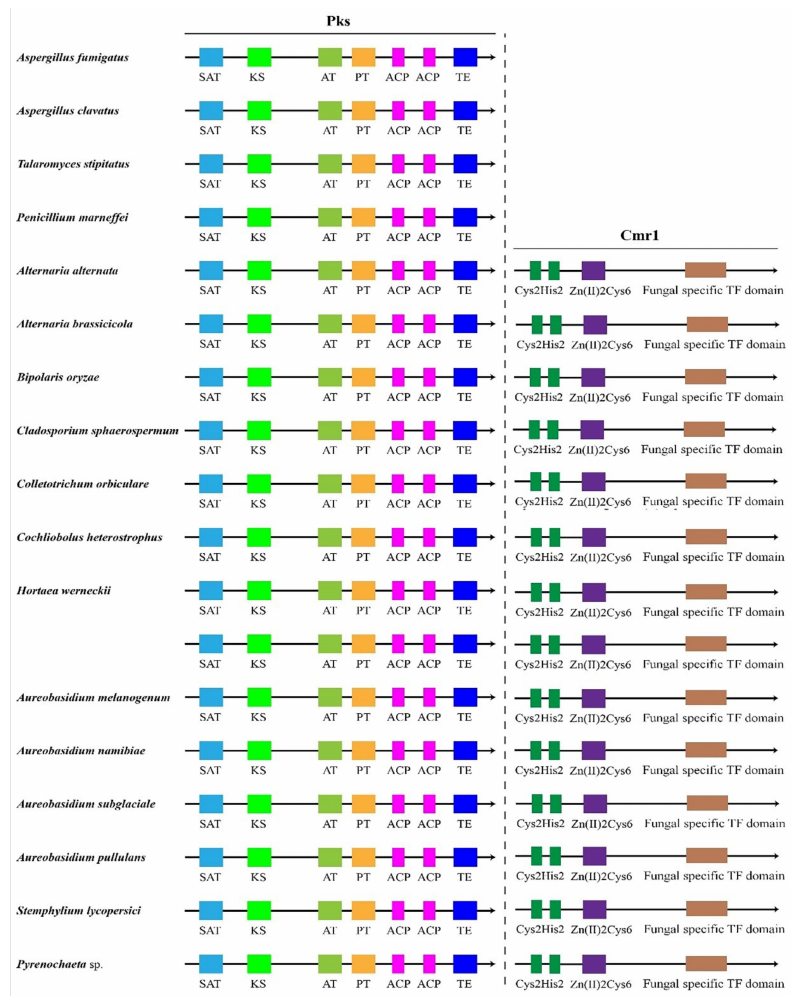
Figure 5. Transcription factor Cmr1 and the target protein Pks1 in different